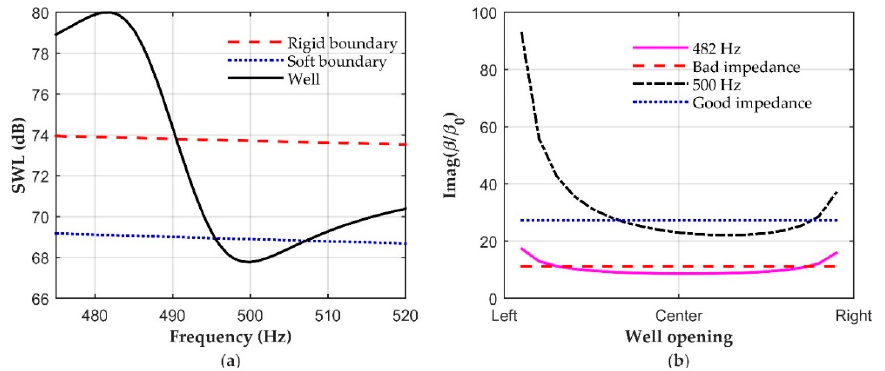
Figure 7. ( a ) The SWL flowing from Σ 2 to Space III; ( b ) the equivalent normal admittance at the opening of the well, where bad impedance is for β = 11.2j β 0 and good impedance is for β = 27.3j β 0 .